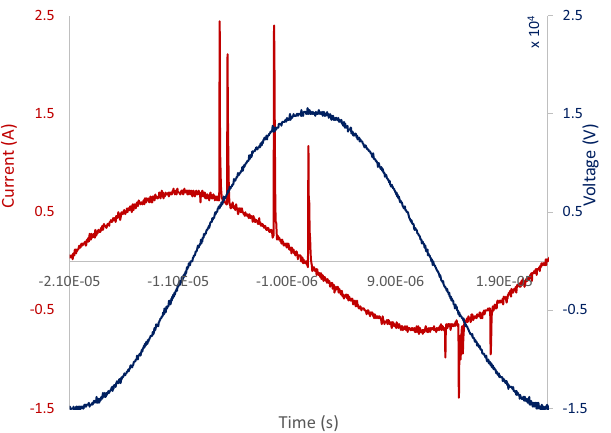
Figure 9. JDBD current and voltage oscillograms.